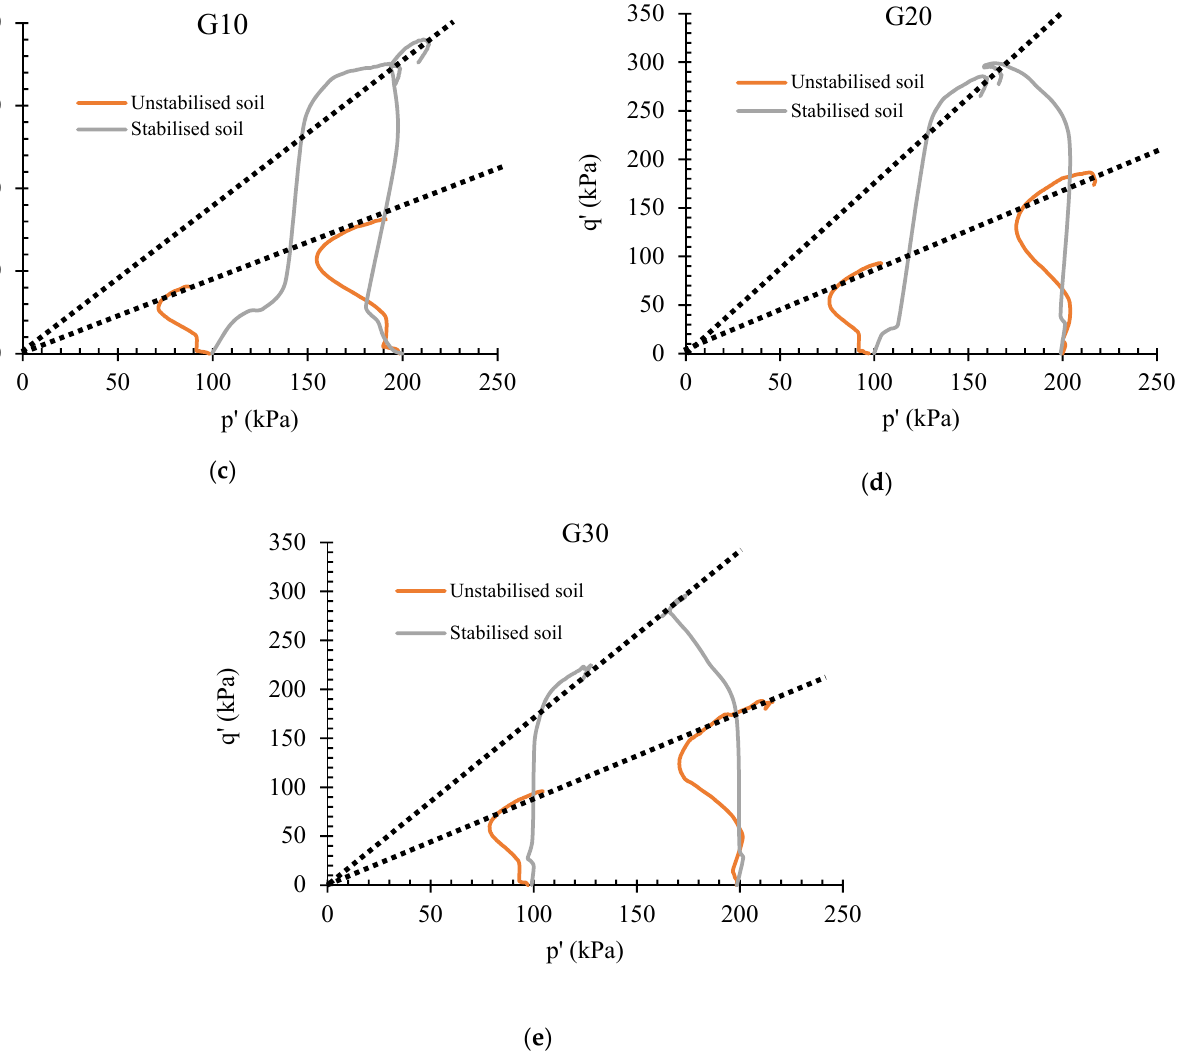
Figure 6. Stress path in p–q space: ( a ) unstabilised soils; ( b ) stabilised soils; ( c ) 10% gypsum content for unstabilised and stabilised soils; ( d ) 20% gypsum content for unstabilised and stabilised soils; ( e ) 30% gypsum content for unstabilised and stabilised soils. Figure 7 indicates the behaviour of the samples at failure. The pattern of failure for